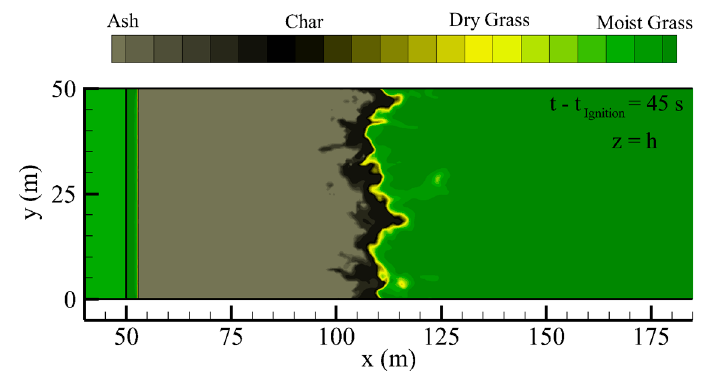
Figure 11. Distribution of the fuel composition at the grassland surface ( z = h ), obtained 45 s after ignition ( t Ignition = 1000 s in phase 2) in the case of U 10 = 5 m / s, showing the position of the fire front.